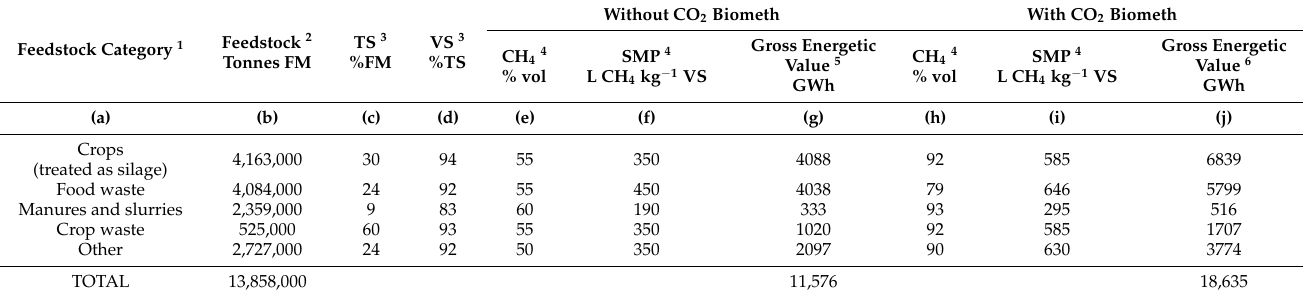
Table 3. Potential uplift in gross energetic value through CO 2 biomethanisation of reported UK feedstocks (Defra